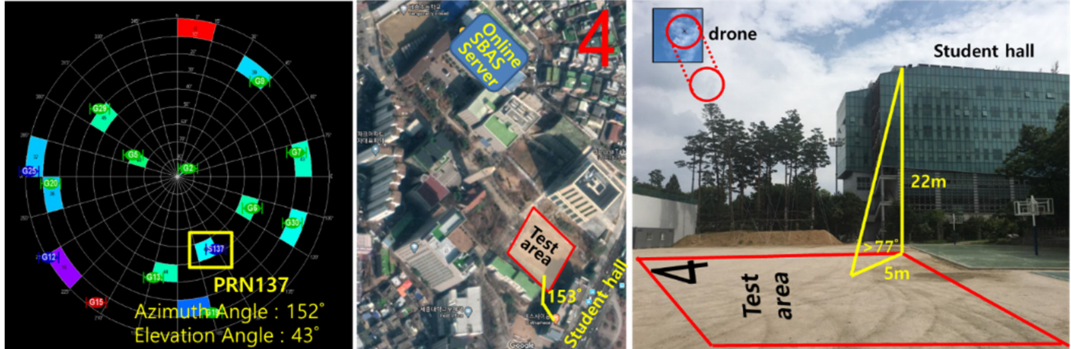
Figure 12. Experimental location and environment ( left side : direction of PRN 137, middle : map of test area, right side : view of test